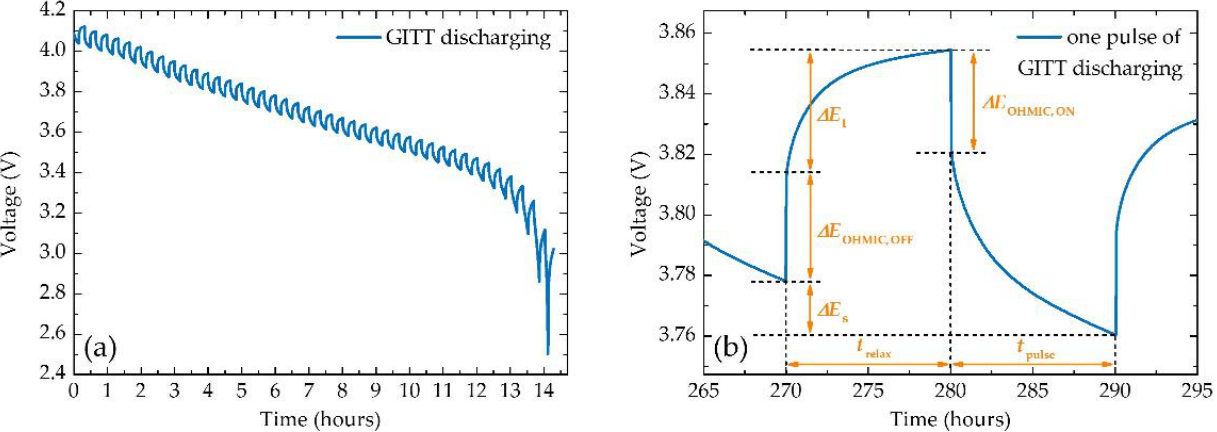
Figure 5. ( a ) Voltage profile of GITT discharging of NCR18650B battery, and ( b ) close-up view of one GITT pulse with highlighted parameters.